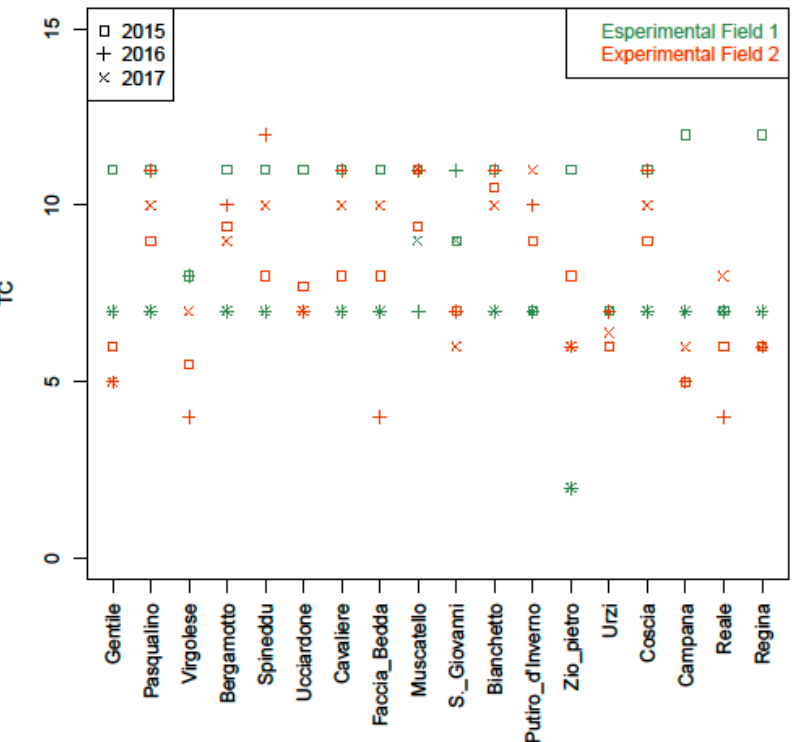
Figure 4. Threshold temperature (TC) expressed in Celsius degrees (°C) of the 18 pear cultivars in both experimental fields (EF1 and EF 2).